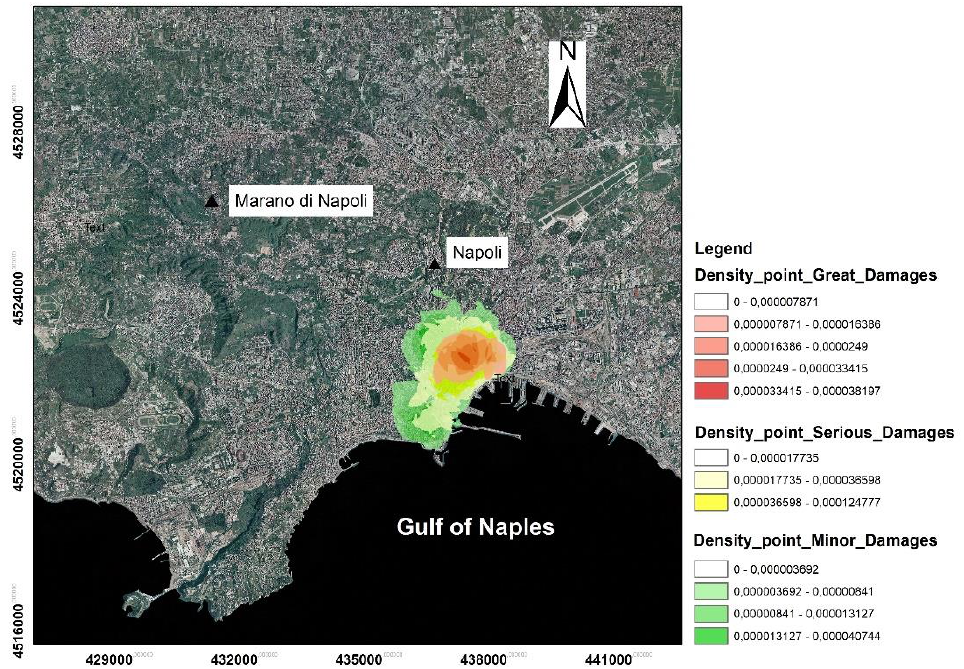
Figure 10. The map shows the areas with the same damage, represented as a density value, for all historical earthquakes felt in the city of Naples.